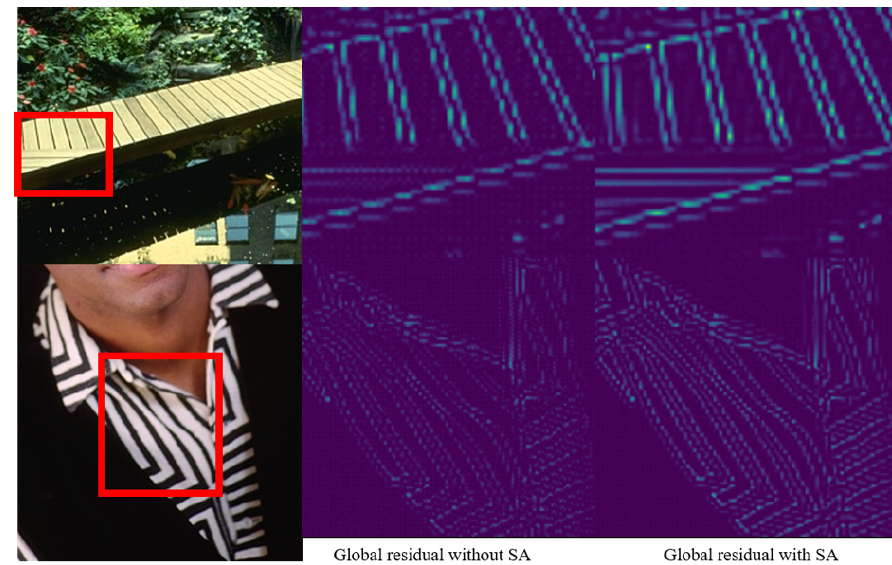
Figure 5. Reconstruction net with spatial